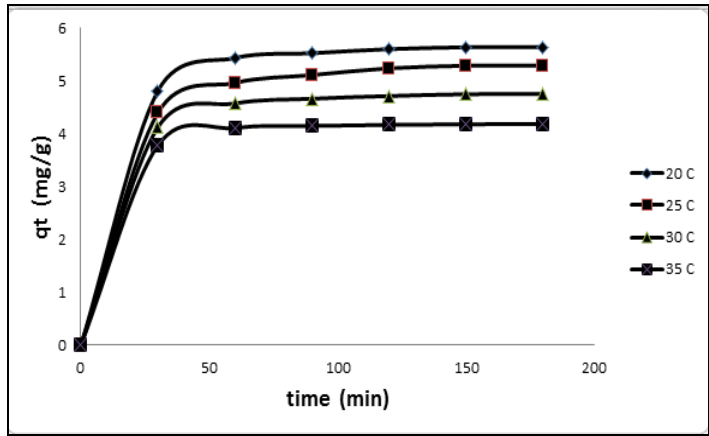
Fig. 7. rate of adsorption for methyl orange adsorbed on super sand at tmpreture range (20−35) °C.